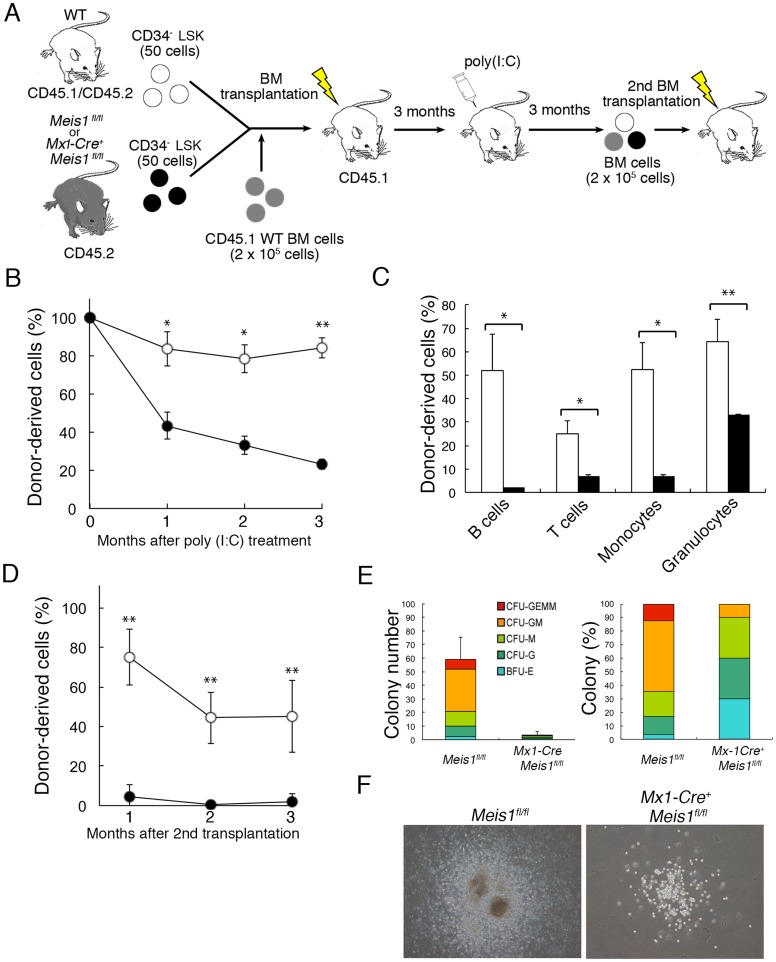
Meis1 regulates self-renewal of HSCs in a cell autonomous manner.(A) Experimental strategy for analyzing the function of Meis1 in HSCs. Mice with chimeric BM were generated by transplanting CD34− LSK cells (50 cells/mouse) from Mx1-Cre
+
Meis1
fl/fl or control Meis1
fl/fl mice (CD45.2) and an equal number of CD34− LSK cells from wild-type mice (CD45.1/CD45.2) with CD45.1 BM supports cells in lethally irradiated CD45.1 recipient mice. A subset of mice was treated with poly(I:C) three months after transplantation. (B) Mean percentages of CD45.2+ cells ± SD in the peripheral blood derived from Meis1
fl/fl (n = 6; open circles) and Mx1-Cre+ Meis1
fl/fl (n = 6; closed circles) CD34− LSK cells after poly(I:C) treatment. Initial engraftment of CD45.2+ was normalized to 100% for each mouse. *p<0.05 and **p<0.01. (C) Histogram represents mean (± SD) contribution of the indicated splenic cell populations derived from Meis1
fl/fl (n = 6; open bars) and Mx1-Cre
+
Meis1
fl/fl (n = 6; solid bars) CD34− LSK cells three months after poly(I:C) treatment. *p<0.05 and **p<0.01. (D) Mean percentages of CD45.2+ cells ± SD in the peripheral blood derived from Meis1
fl/fl (n = 6; open circles) or Mx1-Cre+ Meis1
fl/fl (n = 6; closed circles) CD34− LSK cells after secondary transplantation. *p<0.05 and **p<0.01. (E) Total numbers (left) and proportions (right) of different colony types produced by CD34− LSK cells from poly(I:C)-treated Mx1-Cre+ Meis1
fl/fl and control Meis1
fl/fl mice (n = 3 per each group). Cultures were assessed on day 14 for granulocyte (CFU-G), monocytes (CFU-M), granulocyte-monocyte (CFU-GM), erythroid (BFU-E) and mixed (CFU-GEMM) colony formation. The data are the means of three-independent experiments. (F) Representative photographs of 14 day colonies derived from CD34− LSK cells from poly(I:C)-treated Mx1-Cre+ Meis1
fl/fl- and control Meis1
fl/fl mice (×40 magnification).